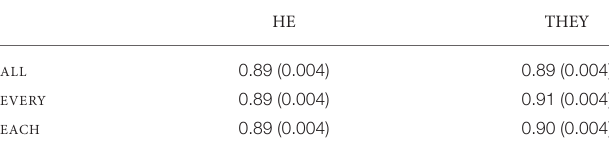
TABLE 3 | The proportion of correct responses (SE), Experiment 3.